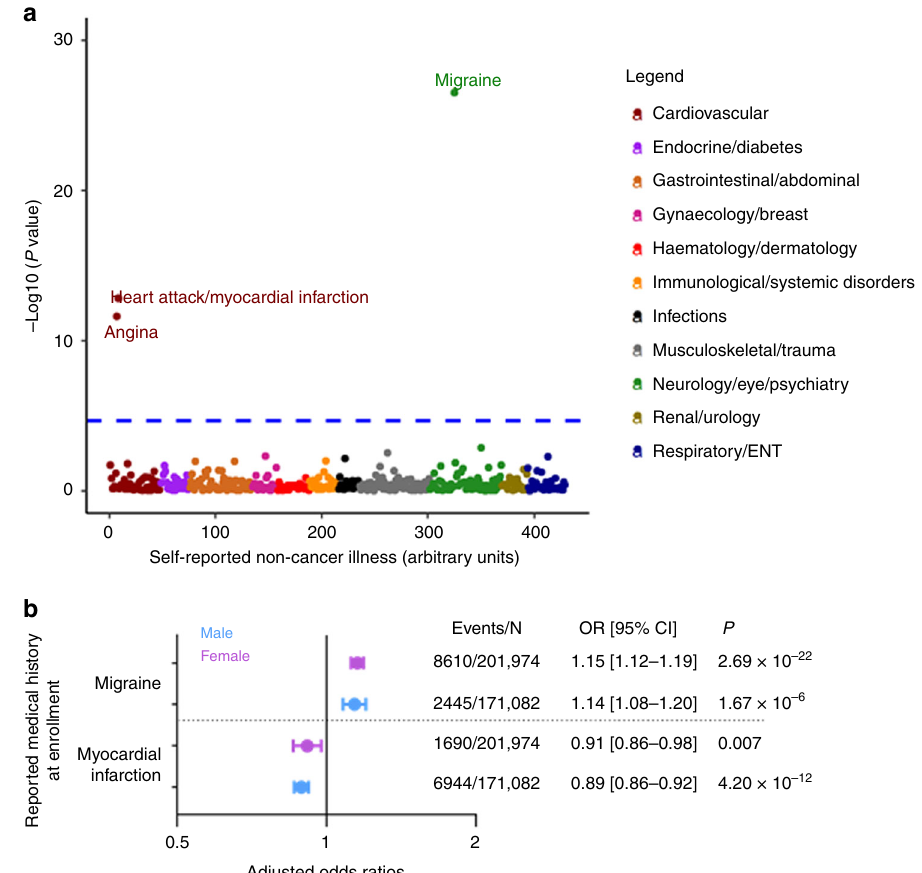
Fig. 5 PheWAS phenotypic associations in the UK Biobank. a PheWAS of the PRS SCAD vs. self-reported non-cancer medical illnesses in the UK Biobank ( n = 373,015). The different color dots represent the association results (logistic regression two-sided test P values in minus log base ten scale) of the PRS SCAD for non-cancer illness categories. Two-sided P values were considered signi fi cant when below a Bonferroni-adjusted threshold (0.05/2356 ≈ 2.12 × 10 − 5 ). b Sex-speci fi c ORs in blue circles for males ( n = 171,082) or purple circles for females ( n = 201,974) are shown in the center of the corresponding 95% con fi dence interval (CI) from the PRS SCAD analysis for migraine headache and MI, with two-sided values of P values displayed. Events in the legend denote the number of migraine cases or MI cases among the female or male groups, with N shown for the total sample size for each group. The models were adjusted for age at enrollment, genetic sex, genotyping array and batch, and the fi rst four PCs. The logistic regression Wald statistic of two-sided P values are